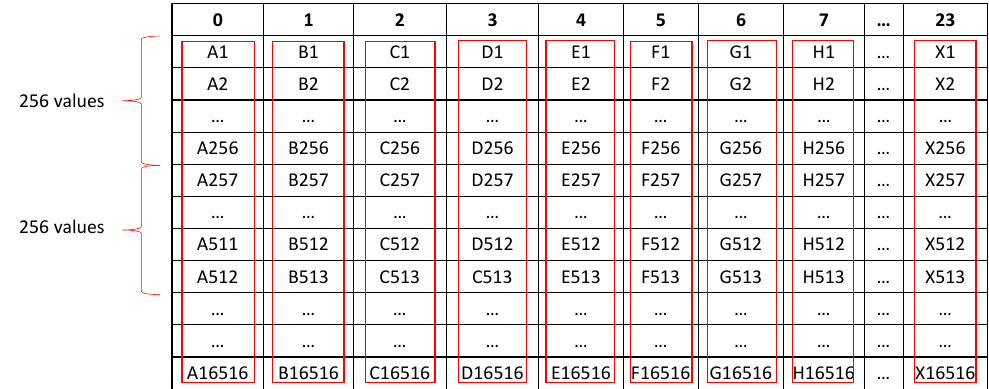
Figure 5. Selection of 256 sequential values for each